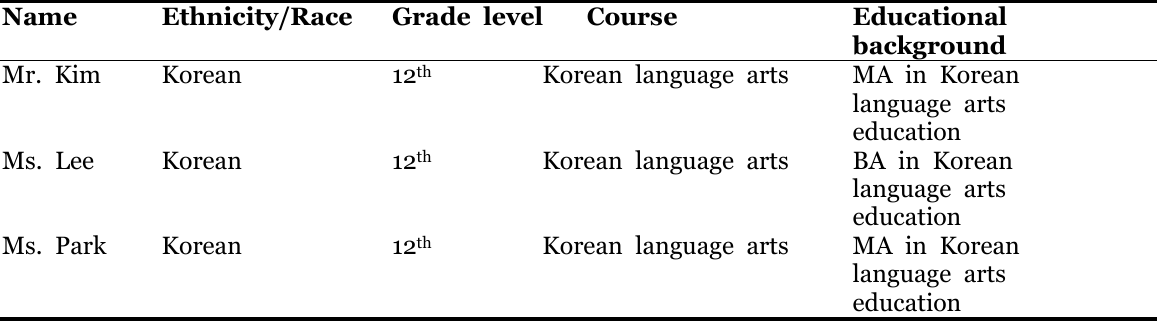
Information about Case Study